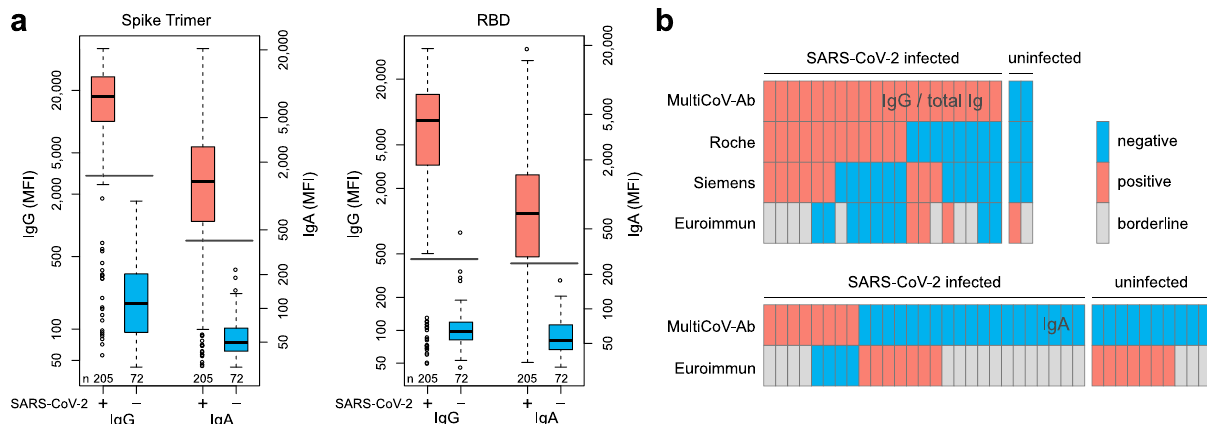
Fig. 1 MultiCoV-Ab, a sensitive and speci fi c tool to monitor SARS-CoV-2 antibody responses. a Control sera (blue, n = 72) and sera from individuals with PCR-con fi rmed SARS-CoV-2 infection (red, n = 205) were screened in a multiplex bead-based assay using Luminex technology (MultiCoV-Ab) to quantify IgG or IgA responses to various antigens. Reactivity towards trimeric SARS-CoV-2 spike protein (Spike Trimer) or SARS-CoV-2 receptor binding domain of spike (RBD) was found to be the best predictor of SARS-CoV-2 infection. Data are presented as Box-Whisker plots of a sample ’ s median fl uorescence intensity (MFI) on a logarithmic scale. Box represents the median and the 25th and 75th percentiles, whiskers show the largest and smallest values. Outliers determined by 1.5 times IQR of log-transformed data are depicted as circles. Cut-off values for classi fi cation for single antigens are displayed as horizontal lines (Spike Trimer IgG: 3,000 MFI, IgA: 400 MFI; RBD IgG: 450 MFI, IgA: 250 MFI). b Sample set from a , was used to compare assay performance of the MultiCoV-Ab using Spike Trimer and RBD antigens with commercially available single analyte SARS-CoV-2 IVD assays which detect total Ig (Elecsys Anti-SARS-CoV-2 (Roche); ADVIA Centaur SARS-CoV-2 Total (COV2T) (Siemens Healthineers)) or IgG (Anti-SARS-CoV-2-ELISA - IgG (Euroimmun)) or IgA (Anti-SARS-CoV-2-ELISA - IgA (Euroimmun)). SARS-CoV-2 infection status of samples based on PCR diagnostic is indicated as SARS-CoV-2 positive or negative. Antibody test results were classi fi ed as negative (blue), positive (red), or borderline (gray) as per the manufacturer ’ s de fi nition. Only samples with divergent antibody test results are shown. c Performance and speci fi cations as stated in the manufacturer ’ s IVD assay manual. For the manufacturer sensitivity speci fi cation, information for samples >14 days post-infection are presented. Respective sensitivity and speci fi city values calculated in this study are given with 95% Clopper-Pearson con fi dence intervals 52 . Positive and negative predictive values (PPV/NPV) were calculated based on a seropositivity of 3%. Source data are provided as a Source Data fi